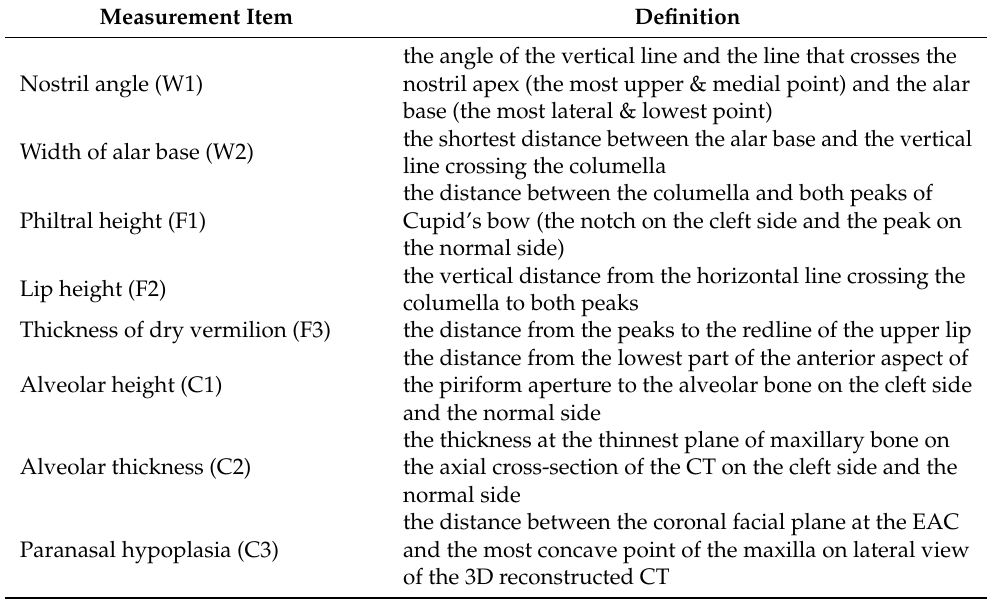
Table 1. Definition of Measurement